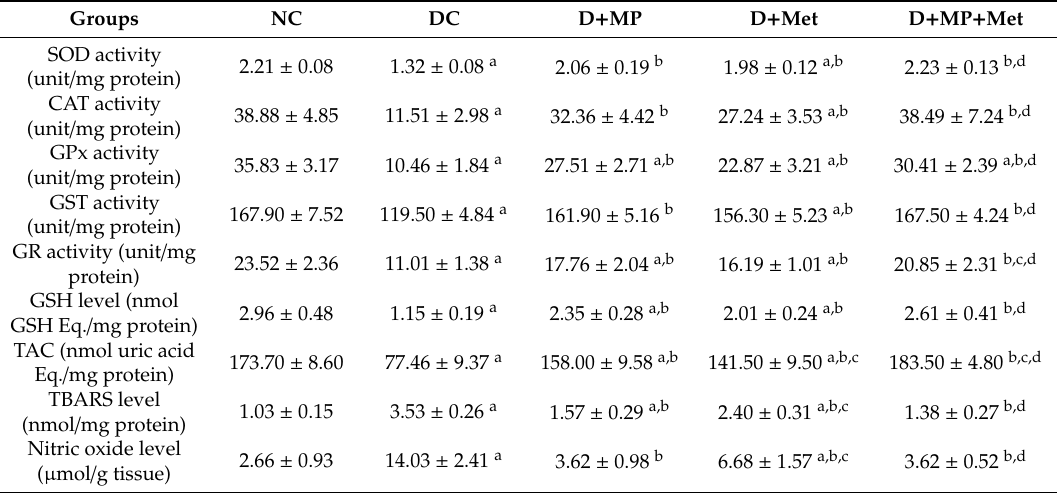
Table 2. Testicular antioxidant enzymes, oxidative stress markers and total antioxidant capacity.